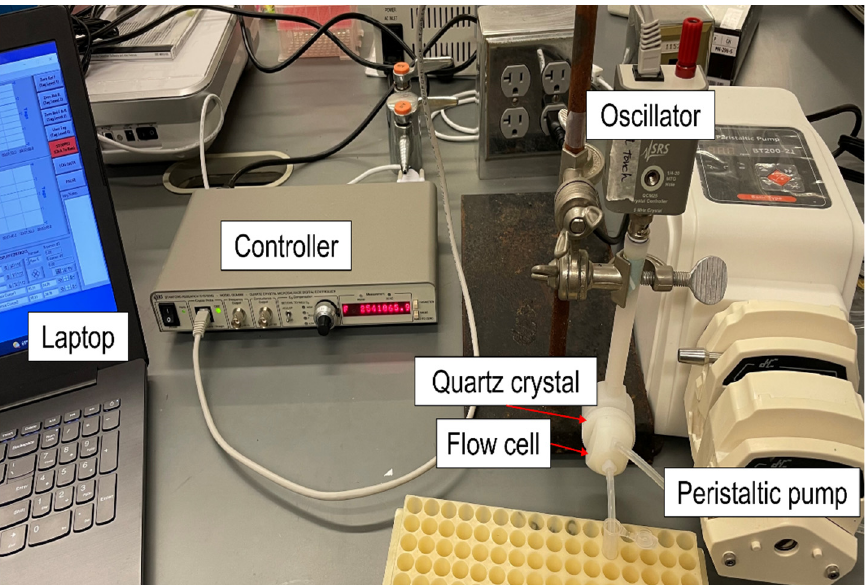
Figure 2. A photo of a QCM benchtop setup for bacteria detection. A controller is connected to an oscillator and a laptop to receive the frequency data. A quartz crystal is installed in a flow cell, and a peristaltic pump allows the solution to be introduced to the front side of the quartz